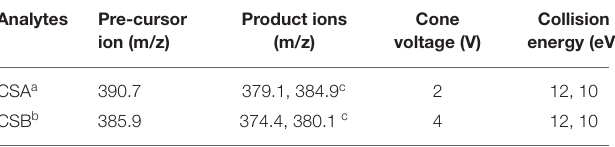
TABLE 1 | Multiple reaction monitoring settings for MS/MS analysis of colistin.